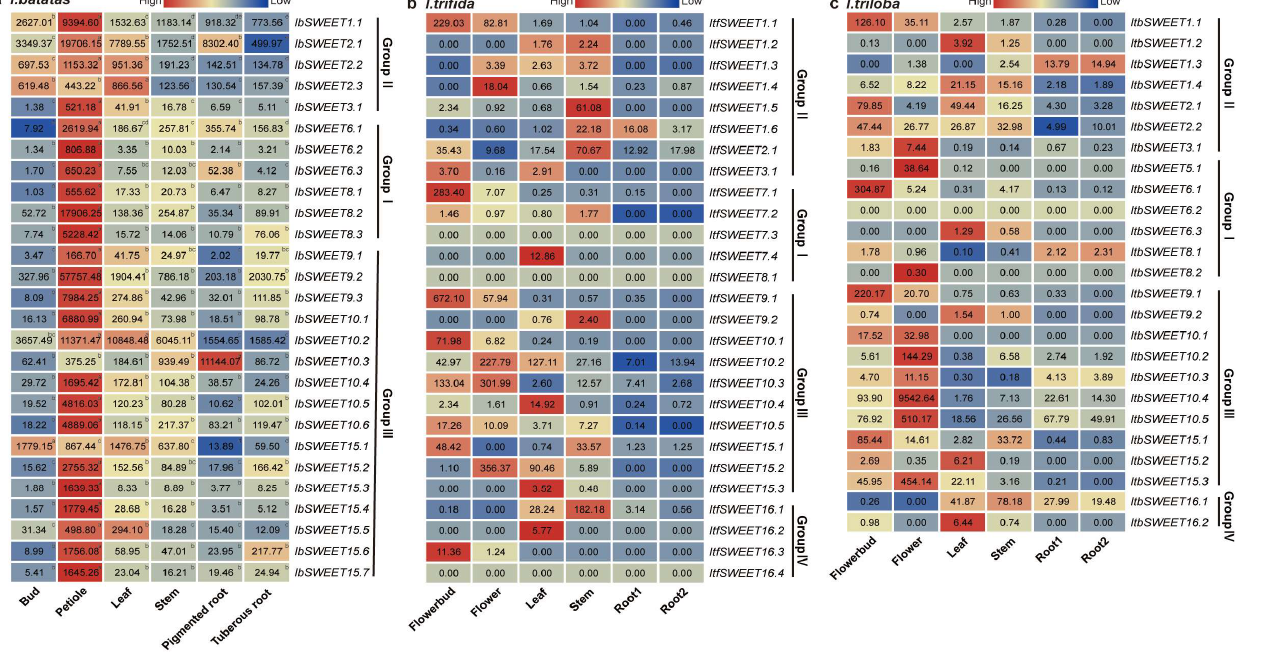
Figure 7. Gene expression patterns of SWEETs in different tissues of I. batatas , I. trifida , and I. triloba. ( a ) Expression analysis in the bud, petiole, leaf, stem, pencil root, and tuberous root of I. batatas . qRT-PCR determined the values from three biological replicates consisting of pools of three plants, and the results were analyzed using the comparative C T method. The expression of IbSWEET8.1 in the buds was considered as “1”. The fold change is shown in the boxes. Different lowercase letters indicate a significant difference in each IbSWEET at p < 0.05 based on the Student’s t -test. ( b ) Gene expression patterns of ItfSWEETs in the flower bud, flower, leaf, stem, root 1, and root 2 of I. trifida as determined by RNA-seq. The log 2 (FPKM) value is shown in the boxes. ( c ) Gene expression patterns of ItbSWEETs in the flower bud, flower, leaf, stem, root 1, and root 2 of I. triloba as determined by RNA-seq. The log 2 (FPKM) value is shown in the boxes.